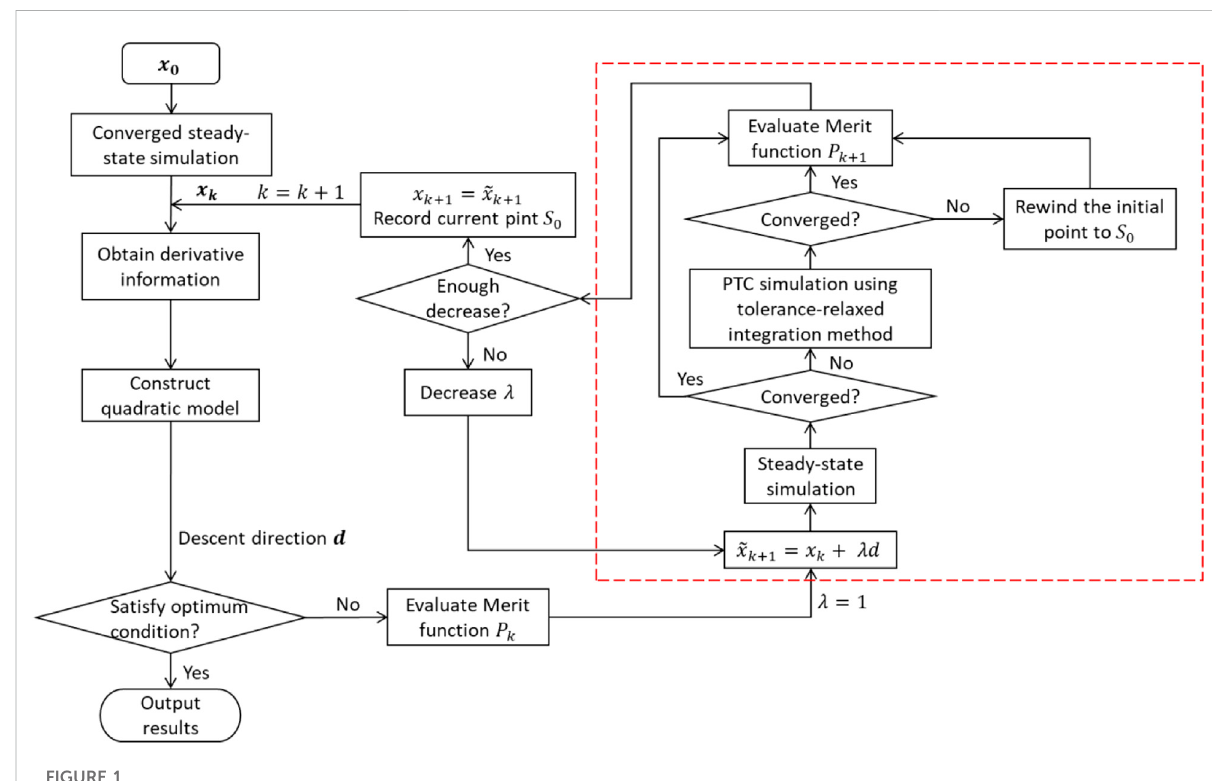
FIGURE 1 Steady state and PTC simulation